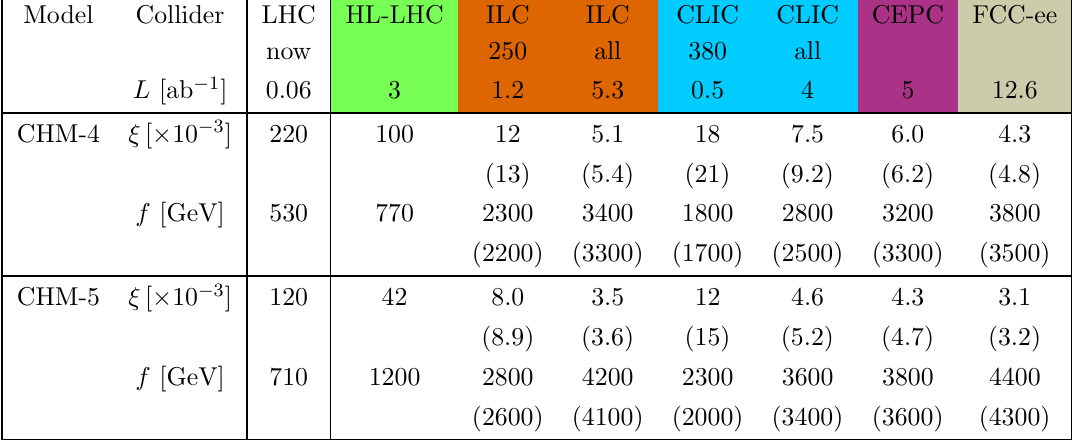
Table 5 . Estimates on the size the CHM ratio (cid:24) = v 2 =f 2 from the intersection of the (cid:24) -lines with the 95.4% probability c i -contours. We also translate the result into the corresponding value of the symmetry breaking scale f . The ILC, CLIC, CEPC and FCC numbers also include the (cid:12)nal HL-LHC results; their individual limits are given in